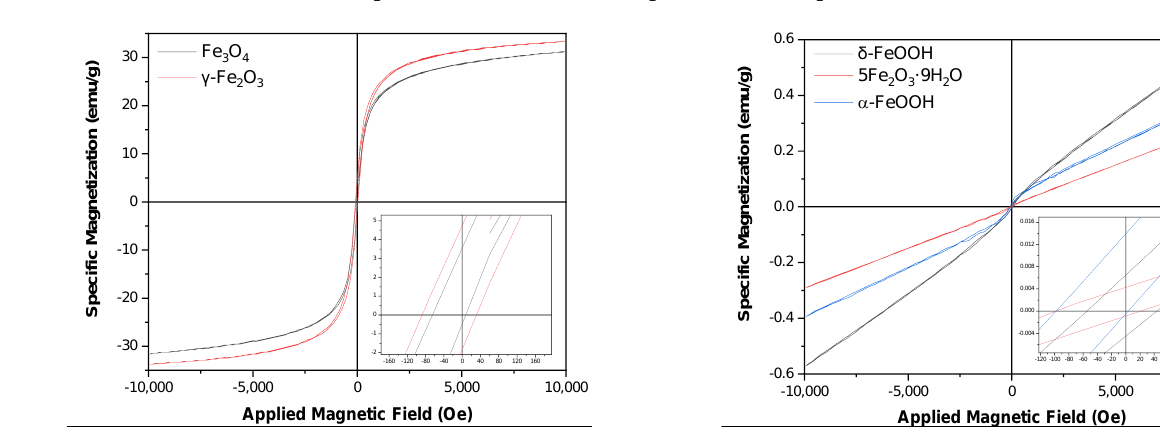
Table 3. Magnetic Table 3. Magnetic parameters.